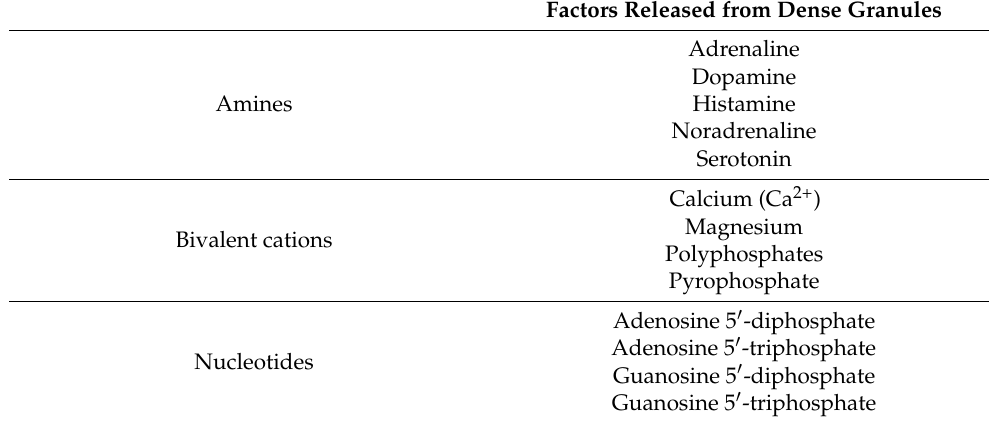
Table 2. Overview of factors released from platelet dense granules [15–21]. These factors within the dense granules are also released upon activation of the platelet specifically following binding of ADP and collagen to the